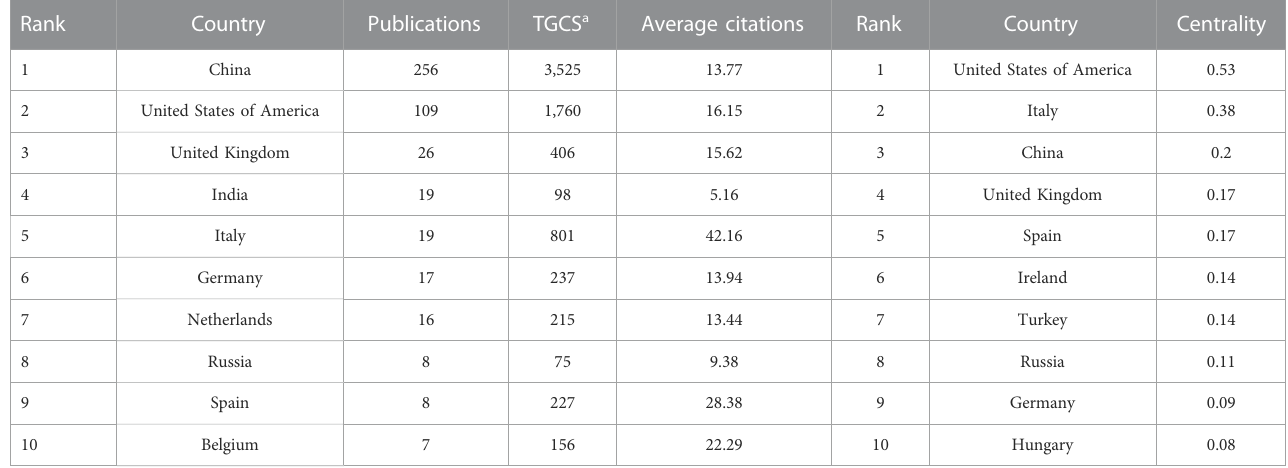
TABLE 1 Top 10 countries by publications, citations and centrality.